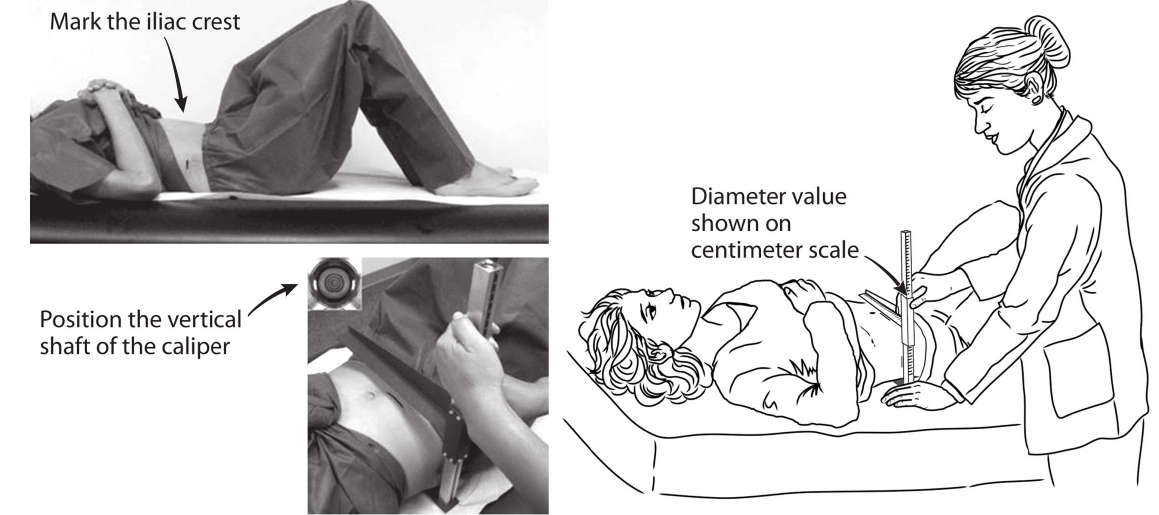
Figure 1. Measurement of the sagittal abdominal diameter by use of a sliding-beam caliper in NHANES, 2011–2012.